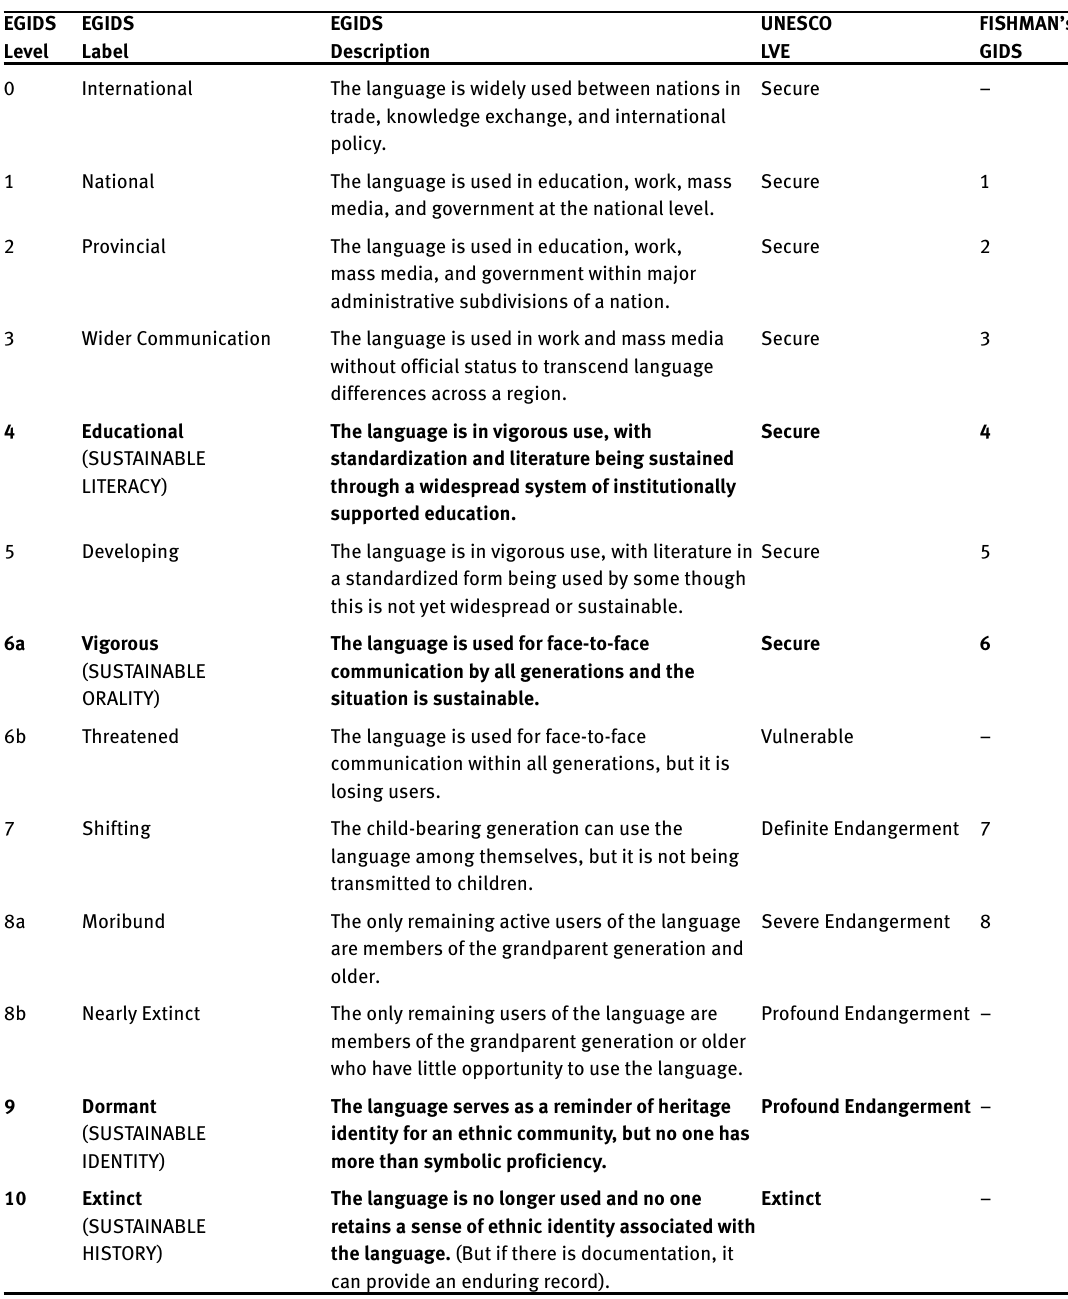
Table 1. The EGIDS (with sustainable levels